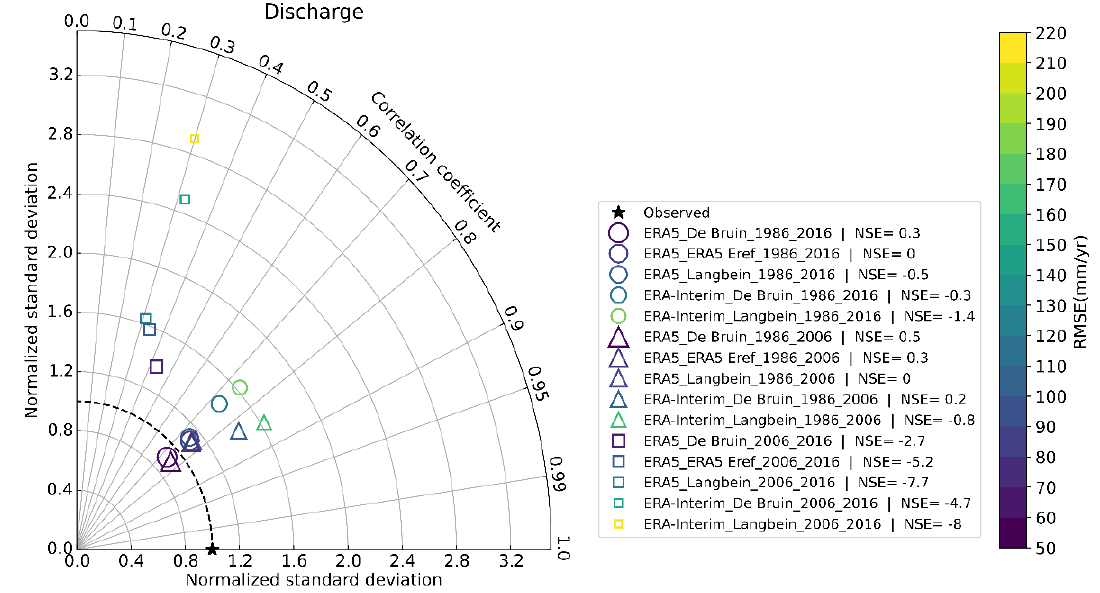
Figure 7. Taylor diagram, RMSE, and NSE comparing the estimated discharge by the GlobWat model using different weather datasets and Eref methods against the observed data in three periods over the Urmia Lake Basin.